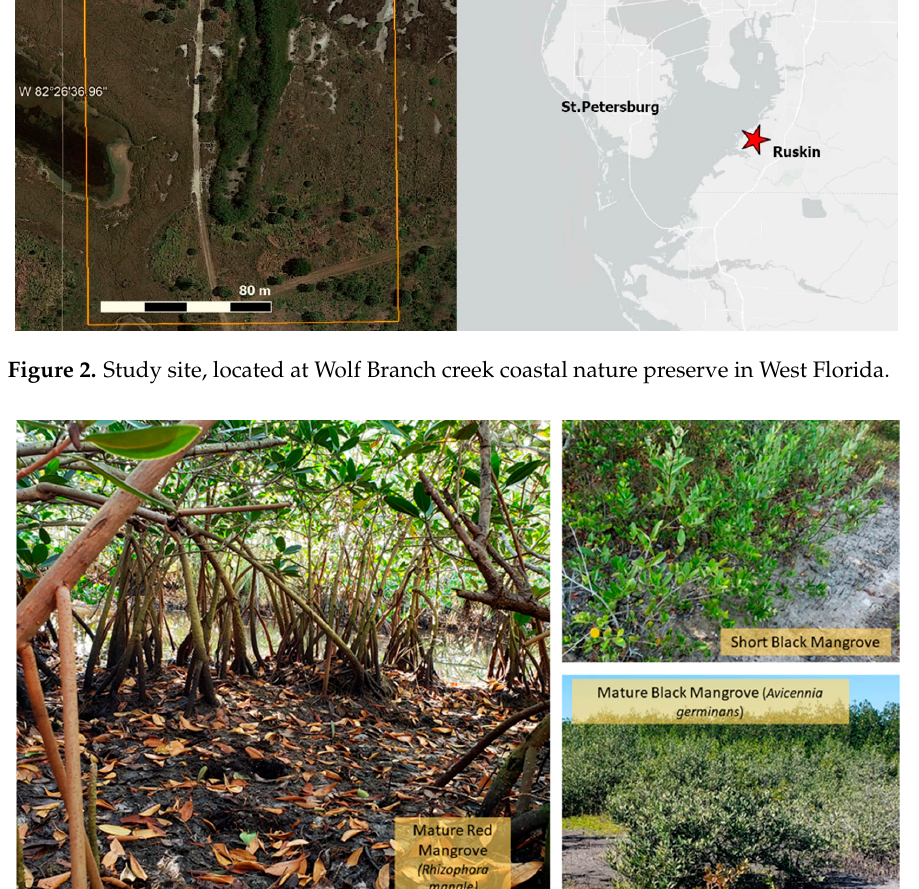
Figure 4. Native grass species naturally occurring as well as used in coastal restoration.